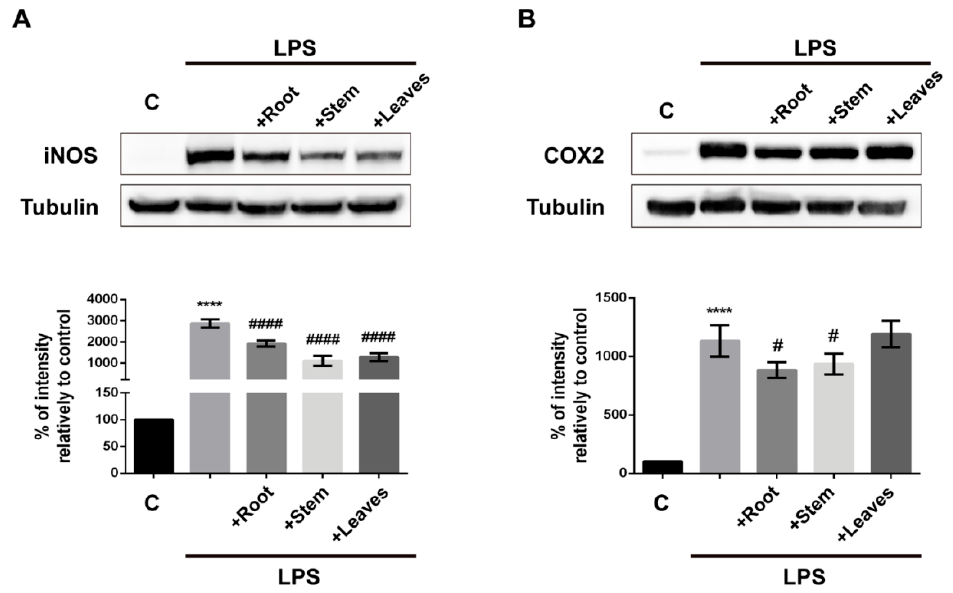
Figure 5. Impact of G. tridentata extracts on the LPS-induced expression of iNOS and COX-2. Cells were exposed to extracts from root, stem, and leaves and then stimulated with LPS. After 24 h total cell lysates were prepared and iNOS and COX-2 protein levels were assessed by Western blot. The results are expressed as percentage of optical densities relative to untreated cells (control). Equal protein loading was controlled using antibody against β -tubulin. A representative blot is shown and each value on graphs represents the mean ± SD of three independent experiments. (**** p < 0.0001: C vs. LPS; # p < 0.05, #### p < 0.0001: LPS vs. extracts + LPS).